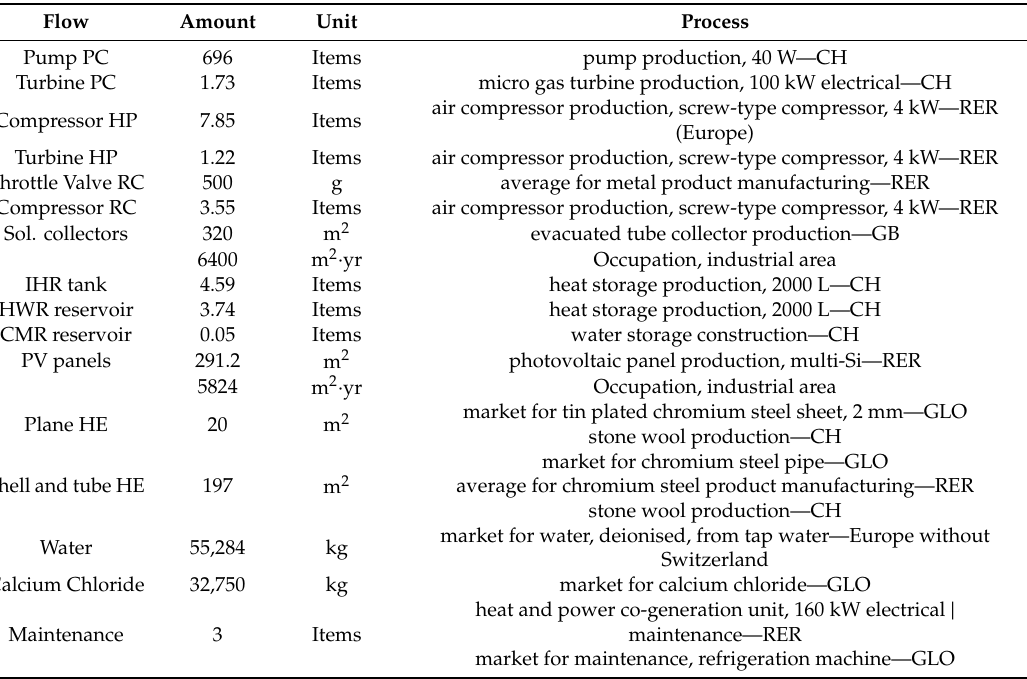
Table 4. Life Cycle Inventory of the TEES